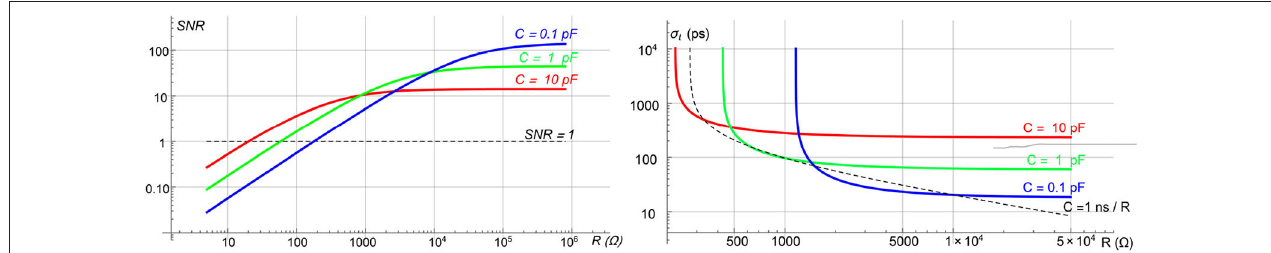
FIGURE 6 | SNR (left) and time precision (right) of a diamond detector vs. the resistor R for different values of C at T indicates SNR 1. On the right, the dashed black line represents the time precision achievable for various C , varying accordingly R to have RC =